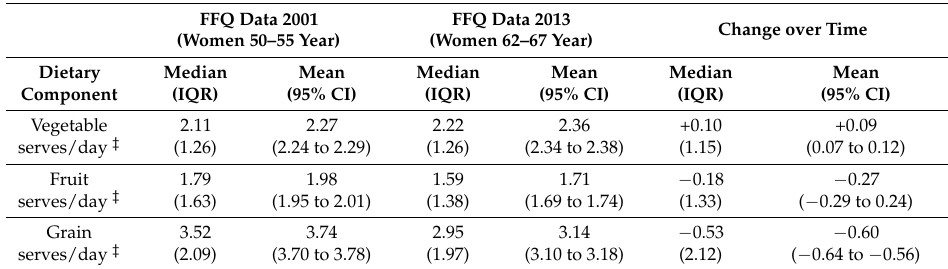
Table 1. Summary and comparison of dietary intakes in 2001 and 2013: Food group serves per day, based on the Australian Dietary